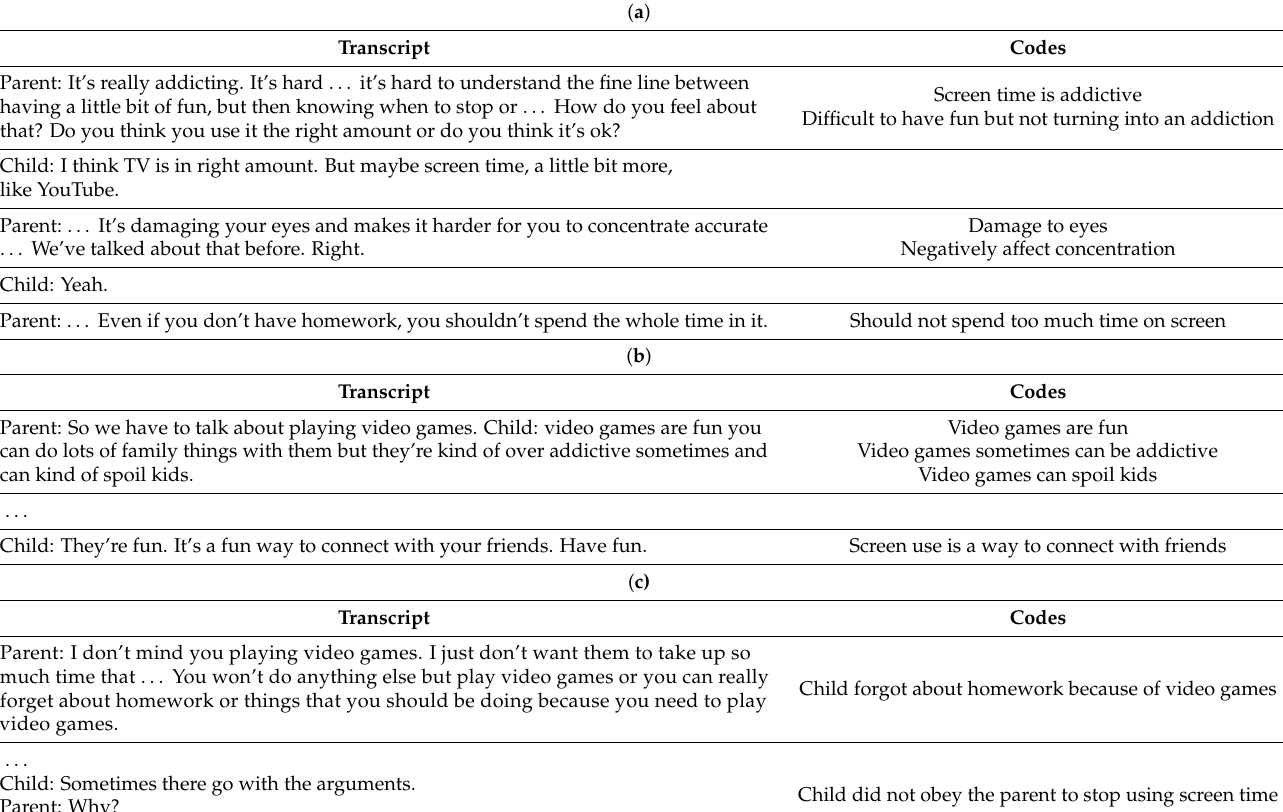
Table 1. ( a ) Example of coded transcript for parental perceptions. ( b ) Example of coded transcript for pre-adolescent perceptions. ( c ) Example of coded transcript for source of